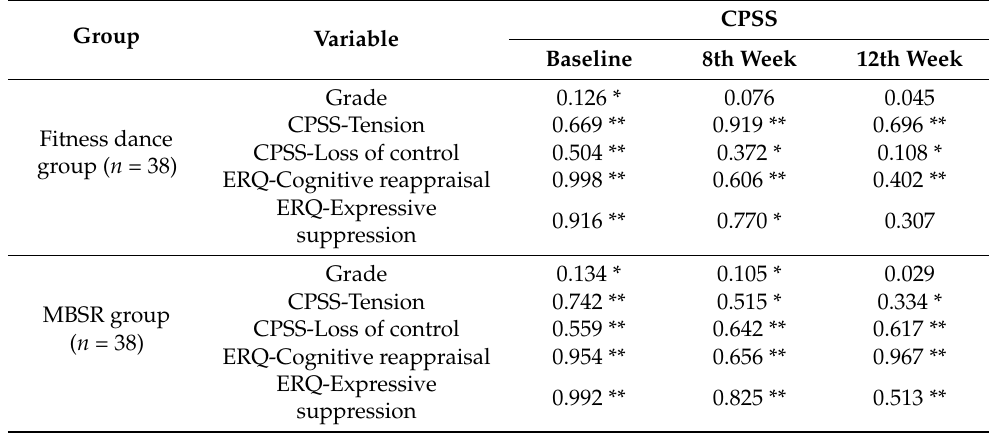
Table 6. Correlation analysis of perceived stress and emotion regulation in the two groups. Group Variable